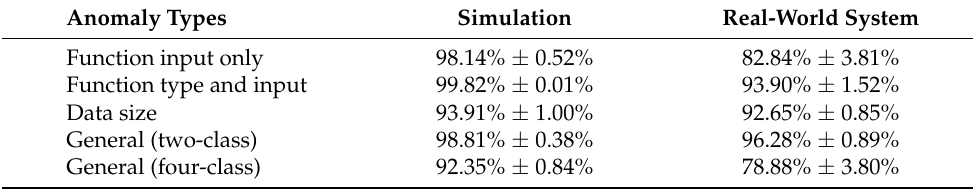
Table 3. Accuracy of LSTM-based anomaly detection.